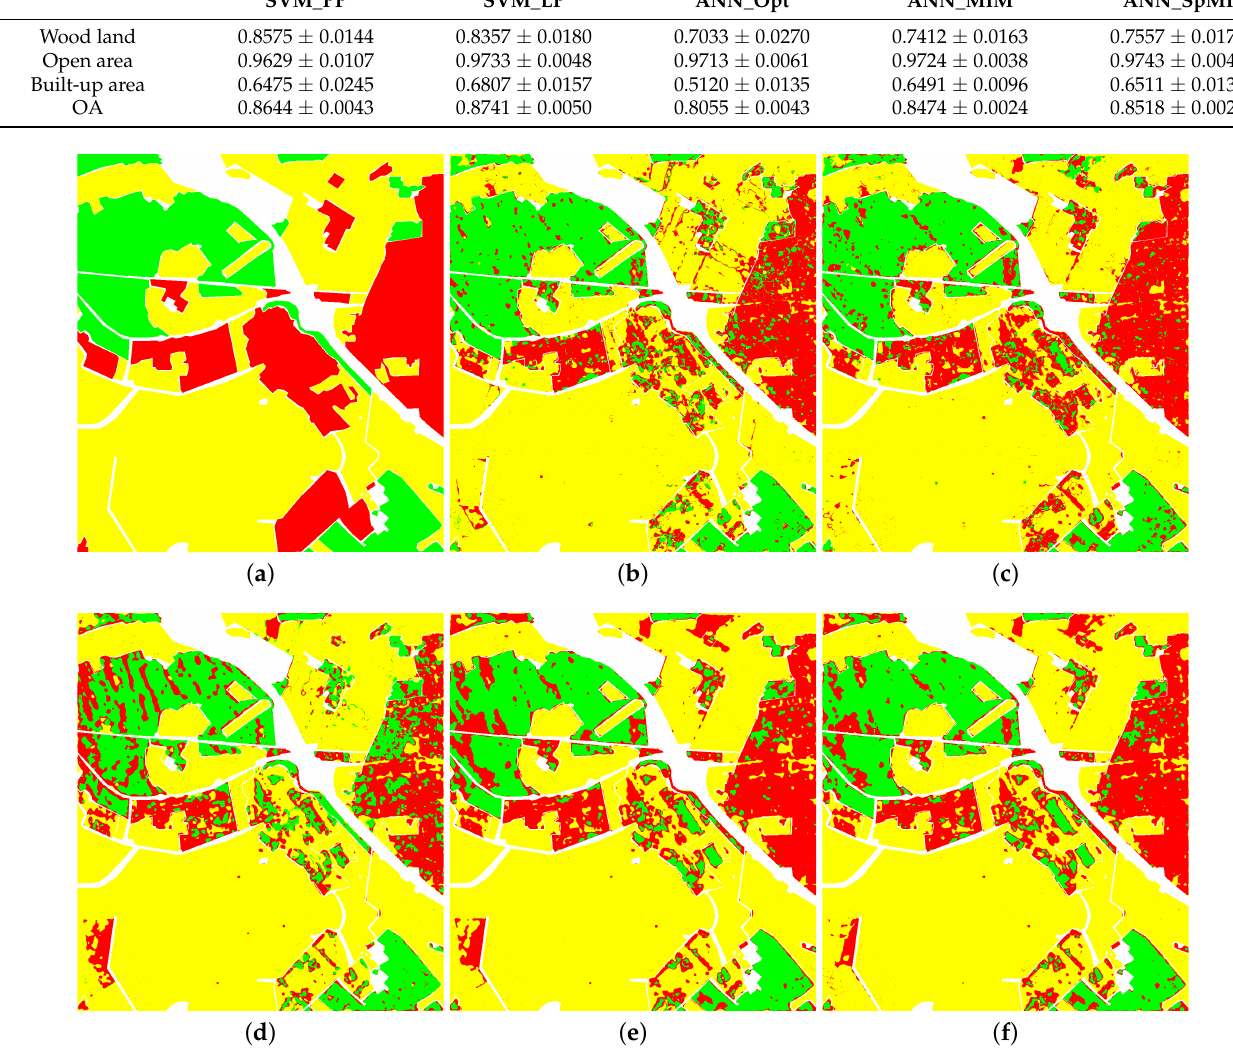
Figure 12. Classification results of five classifiers on the ground-truth map of Oberpfaffenhofen image: ( a )